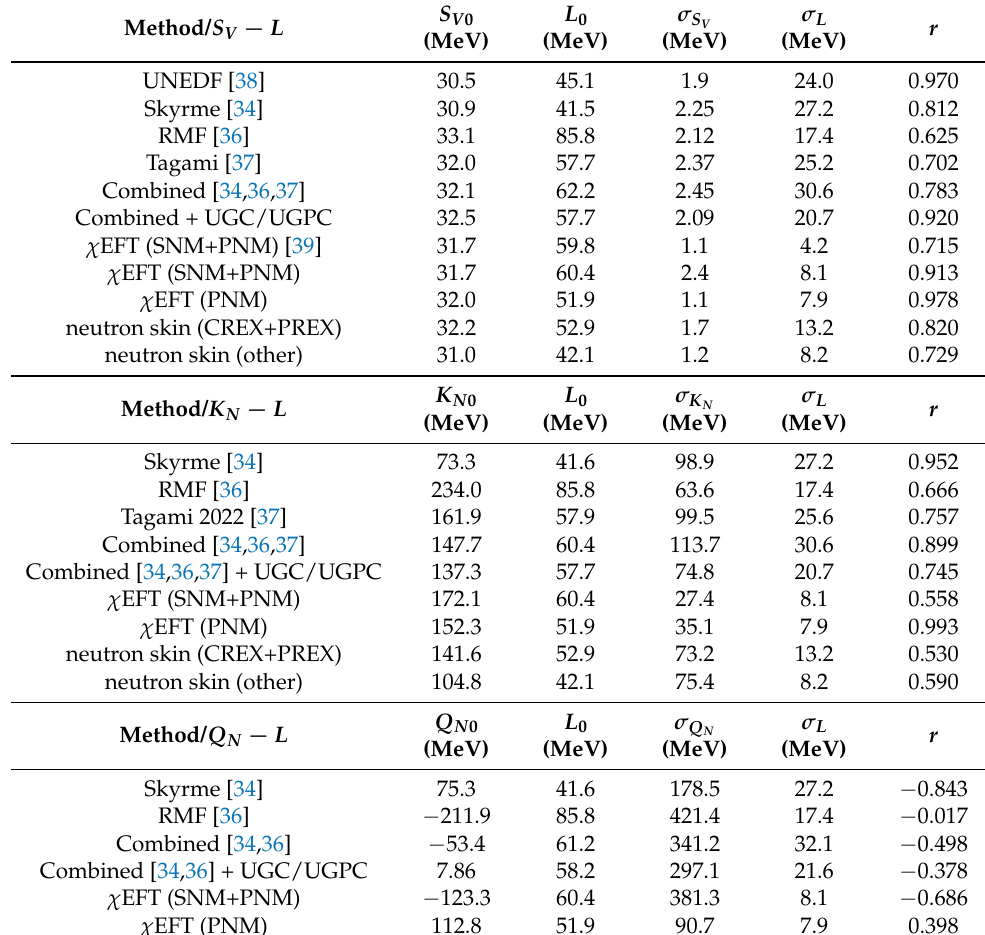
Table 1. Symmetry energy parameter